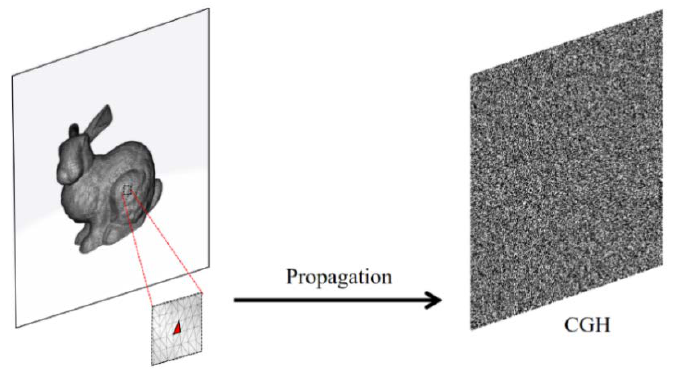
Figure 1. Principle of the polygon-based method.